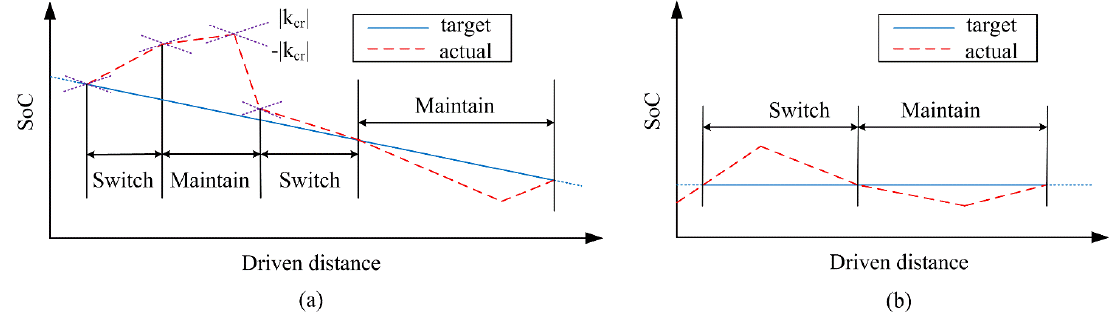
Figure 6. Schematic diagram of the braking work-point switching logic: ( a ) charge depletion (CD) and ( b ) charge sustaining (CS).